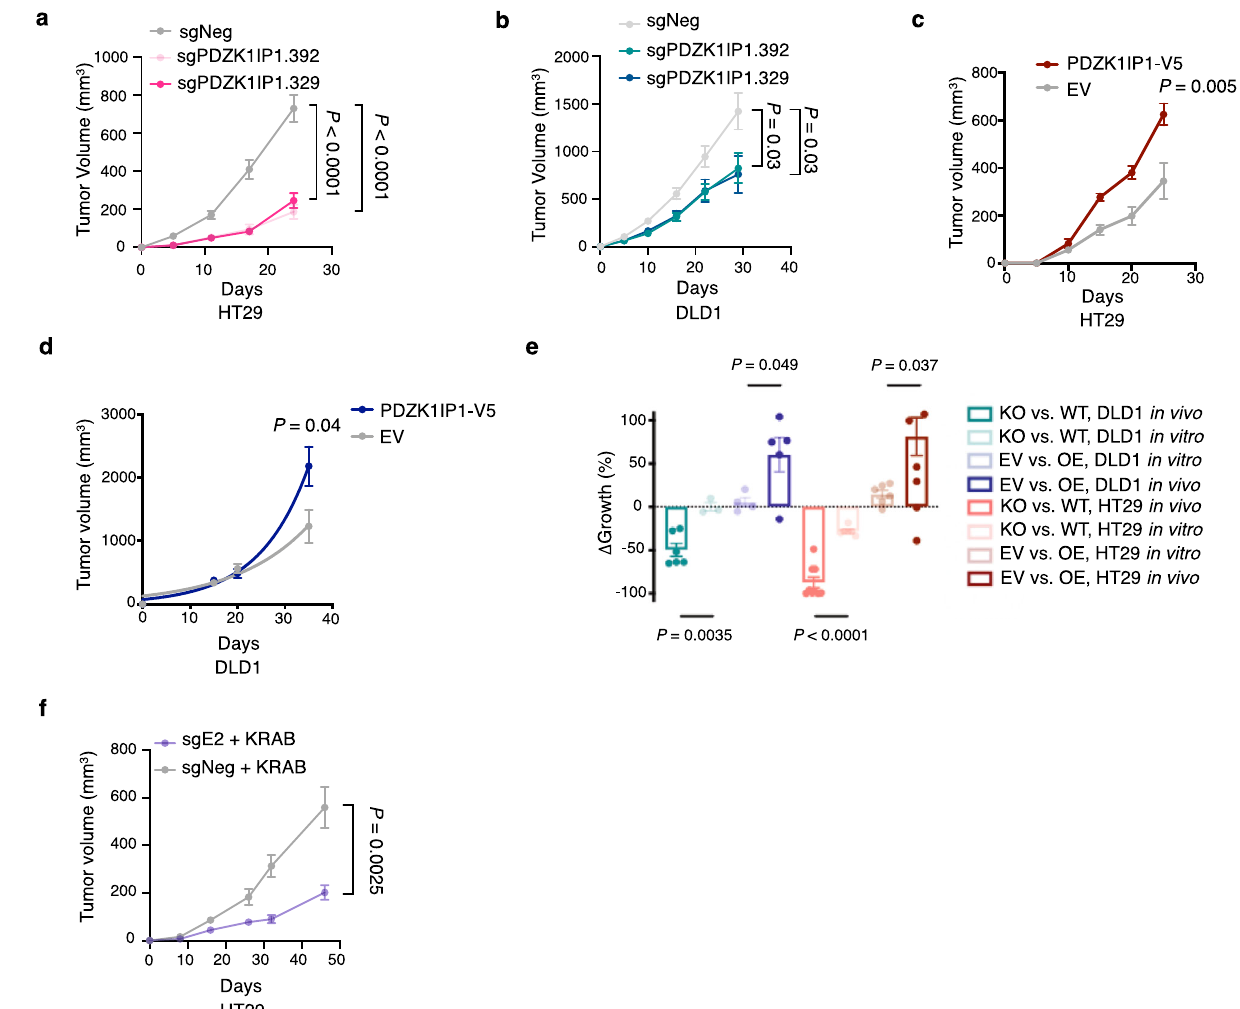
Fig. 6 | PDZK1IP1 is a context-dependent regulator of CRC tumor growth. a , b Growthcurves,sgPDZK1IP1andsgNegsubcutaneousxenografttumorsinnude mice. HT29 n =10 mice per group, DLD1 n =10 mice per group. 1 million cells injected per mouse for both HT29 and DLD1. Data presented as mean ± s.e.m. Signi fi cance was determined using two-sided Student ’ s t -test. c, d Growth curves, PDZK1IP1-V5andEVxenografttumors.HT29 n =10micepergroup,DLD1 n =5mice for PDZK1IP1-V5, n =8 mice for EV. 3-5 million cells injected for both HT29 and DLD1. Data presented as mean ± s.e.m. Signi fi cance was determined using two- sidedStudent ’ s t test. e Meta-comparisonof2DIncucytegrowthcurvesinvitrowith xenograft tumor growth in vivo. KO – sgPDZK1IP1.329, WT – sgNeg, EV – empty